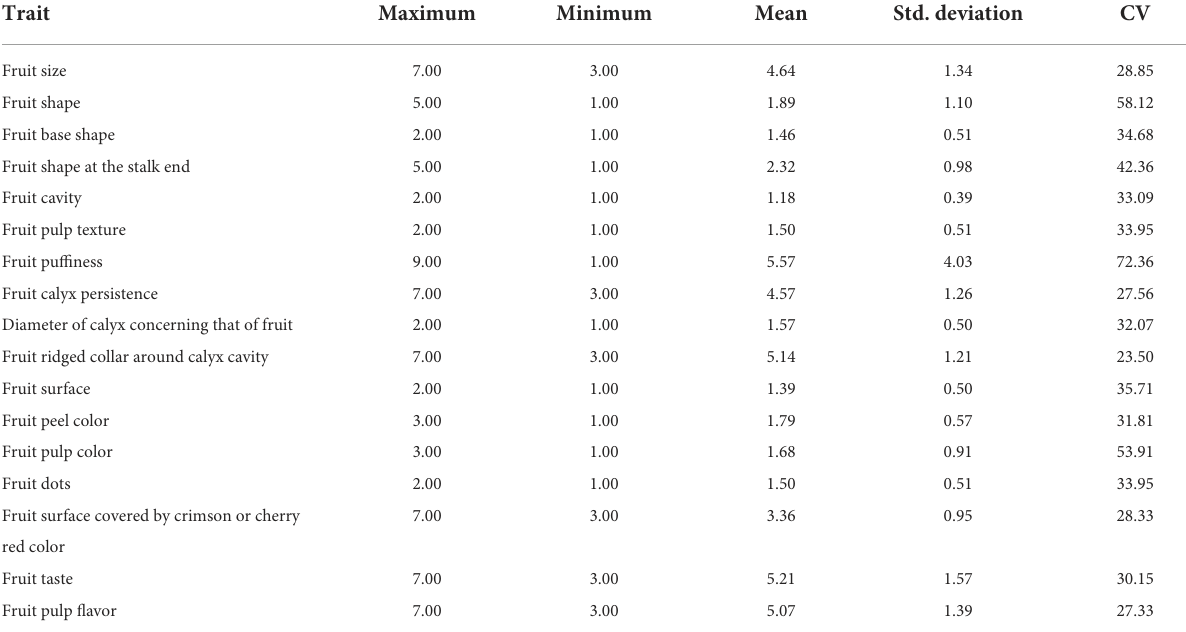
TABLE 2 Descriptive statistics for 17 qualitative traits in 28 guava germplasm.